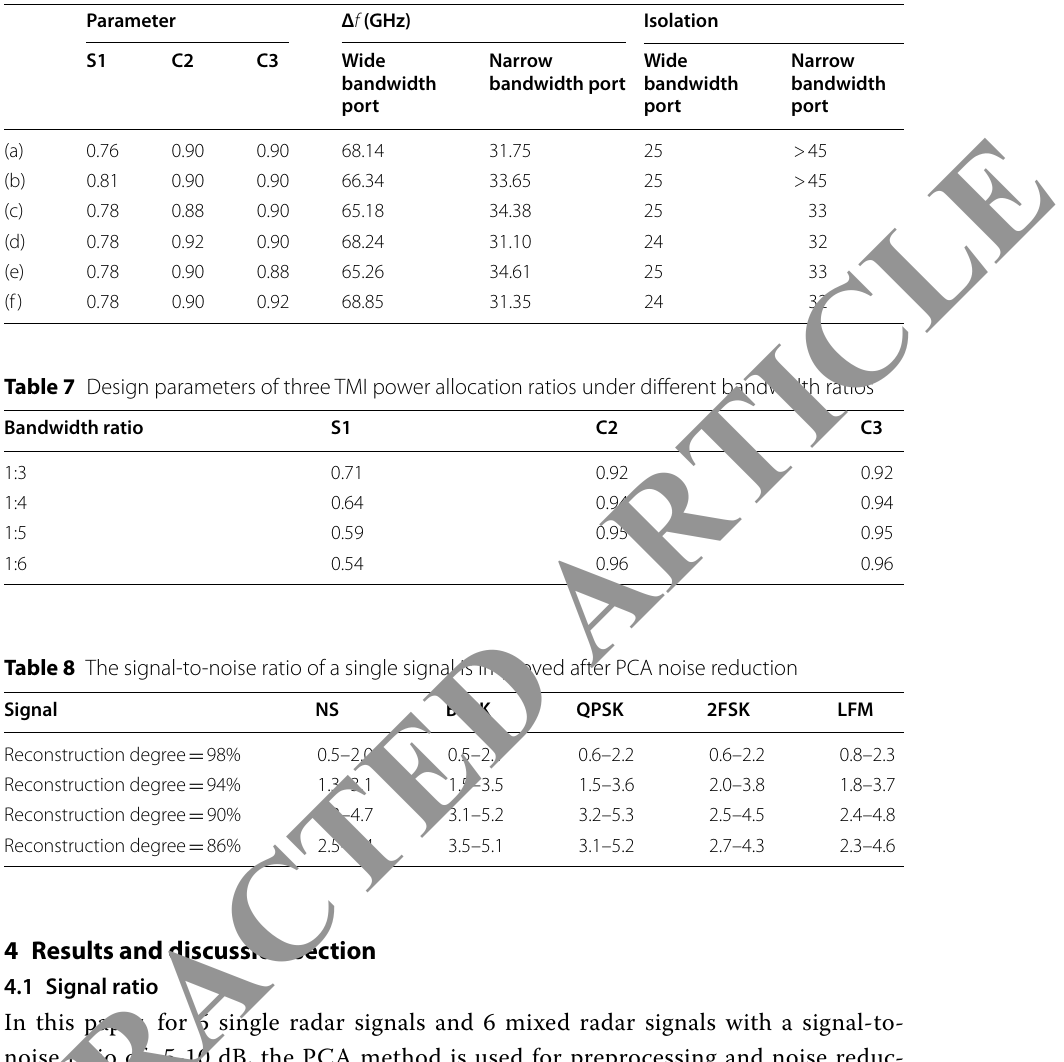
Table 9 is the signal-to-noise ratio of the mixed signal.